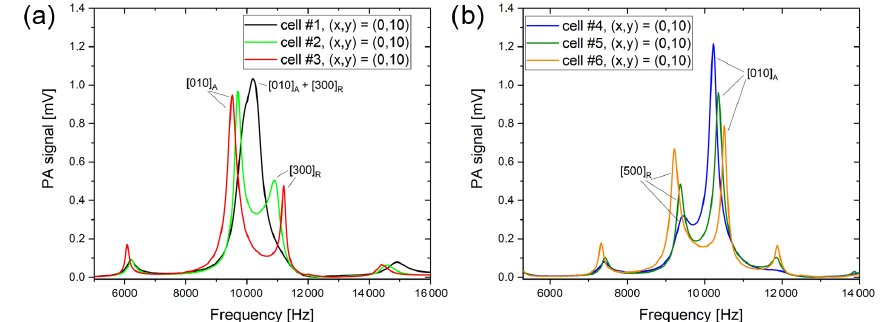
Figure 3. Comparison of the frequency spectra in the range of the first azimuthal mode of the six different cells recorded at a methane concentration of 100ppm, a flow of 300mLmin − 1 , and a laser beam position of ( x,y ) = (0,10) (a) cell number 1 (40_3), cell number 2 (40_6), and cell number 3 (40_9), (b) cell number 4 (80_3), cell number 5 (80_6), and cell number 6 (80_9).